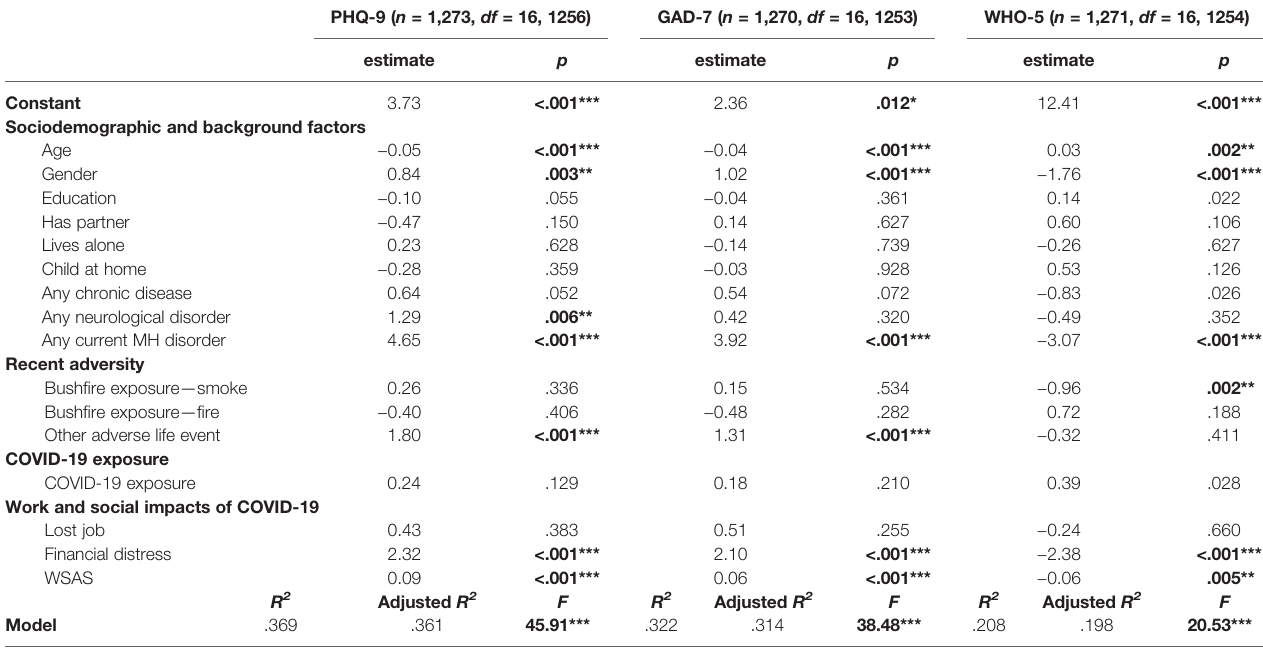
TABLE 4 | Linear regression models for each mental health